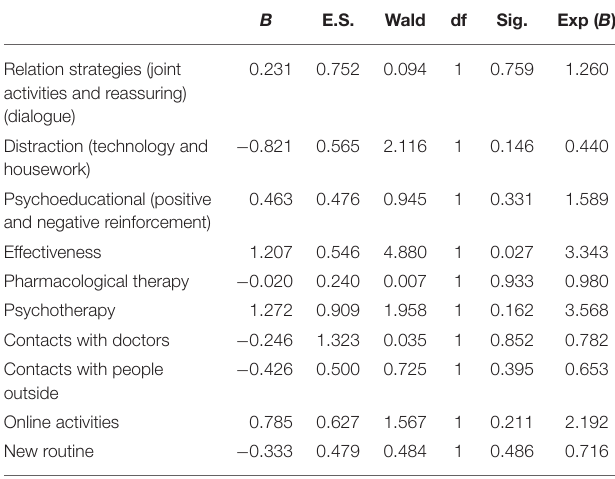
TABLE 13 | Regression between positive factors and not increased symptoms (section